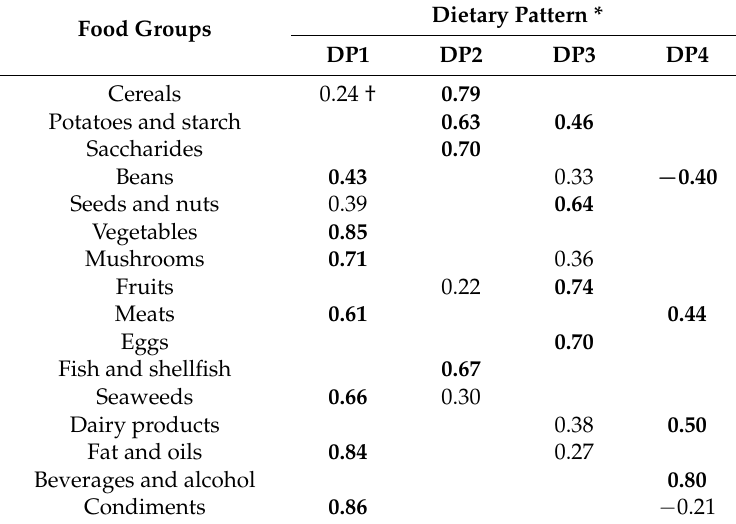
Table 1. Factor loading matrix for the dietary